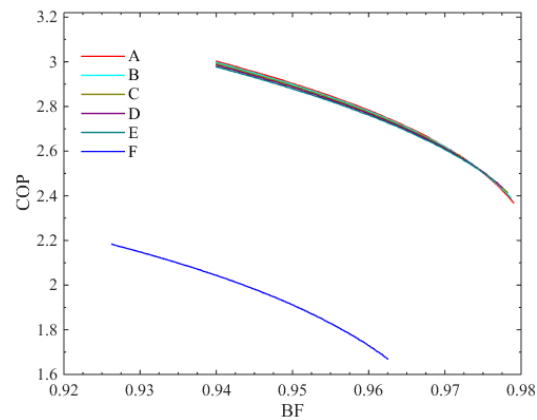
Figure 13. The effect of BF on total energy consumption (TEC).